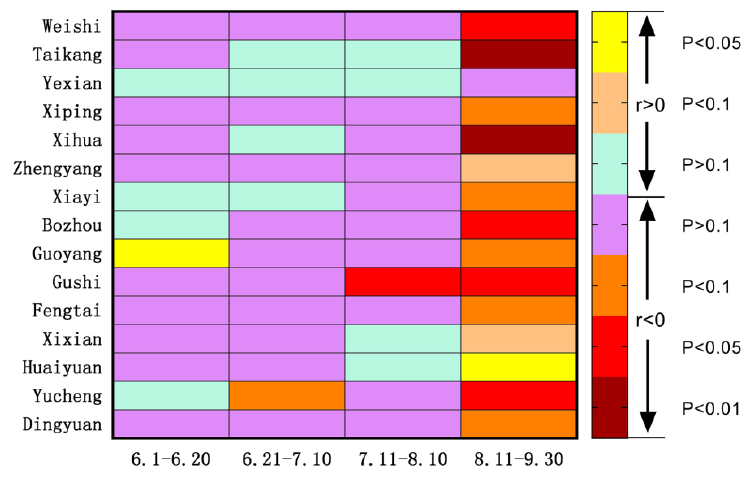
Figure 2. The correlation between climatic yield and water deficit index during the growth period of summer maize at typical